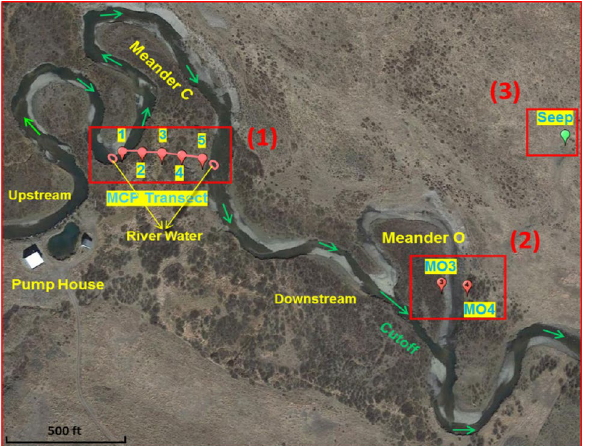
Figure 1. Sampling location for H 2 O 2 detection in the East River floodplain, including three groups of sampling wells: (1) The MCP transect within the intra-meander hyporheic zone, including five piezometric observation wells (MCP1 to MCP5); (2) Two sampling wells (MO3 and MO4) close to the new river channel of Meander O (the “neck cutoff”); (3) One sampling well (Seep) at the Mancos Shale seep (approximately 150 m uphill